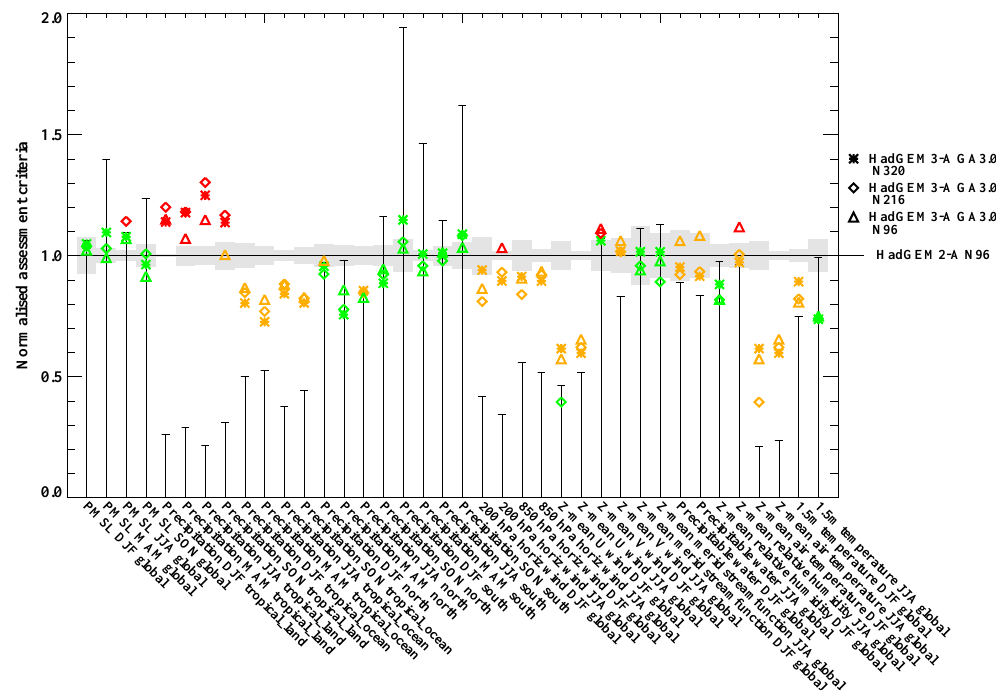
Fig. 2. Normalised assessment criteria (ratios of mean field root mean square errors) for a range of atmospheric fields from GA3.0/GL3.0 HadGEM3-A simulations across a range of resolutions compared to an N96 HadGEM2-A baseline. Statistics shown are from the seasons December to February (DJF), March to May (MAM), June to August (JJA) and September to November (SON) and for regions global, tropical land (land points between 30 ◦ N and 30 ◦ S), tropical ocean (ocean points between 30 ◦ N and 30 ◦ S), north (30 ◦ –90 ◦ N) and south (30 ◦ –90 ◦ S). The observation datasets used are HadSLP2 pressure at mean sea level (Allan and Ansell, 2006), GPCP precipitation (Adler et al., 2003), SSMI precipitable water (Wentz and Spencer, 1998) and CRUTEM3 1.5m temperature (Brohan et al., 2006), whilst the remaining climatologies are from ERA-interim reanalyses (Berrisford et al., 2009). The whisker bars are observational uncertainty, which is calculated by comparing these with alternative datasets; these are ERA-40 pressure at mean sea level and precipitable water (Uppala et al., 2005), CMAP precipitation (Xie and Arkin, 1997), Legates and Willmott (1990) 1.5m temperature and MERRA reanalyses for everything else (Bosilovich, 2008). The grey shading is the uncertainty associated with internal climate variability, which is estimated by comparing various 20yr segments of a long coupled simulation. The points represent simulations of GA3.0/GL3.0 at N96, N216 and N320 resolution, which ran for 30, 30 and 20yr,